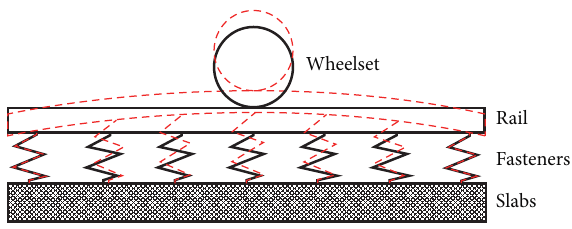
Figure 10: Diagram of the modal shape of P2 resonance.